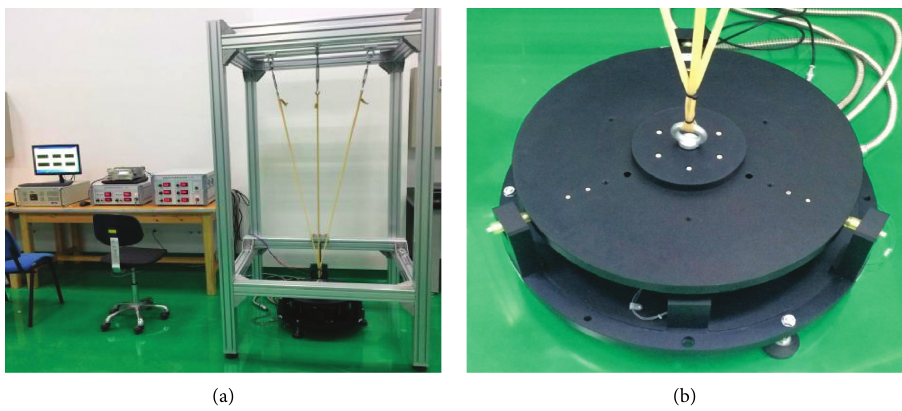
Figure 1: Test device architecture. (a) Overall structure of test device. (b) Noncontact 6-DOF platform.